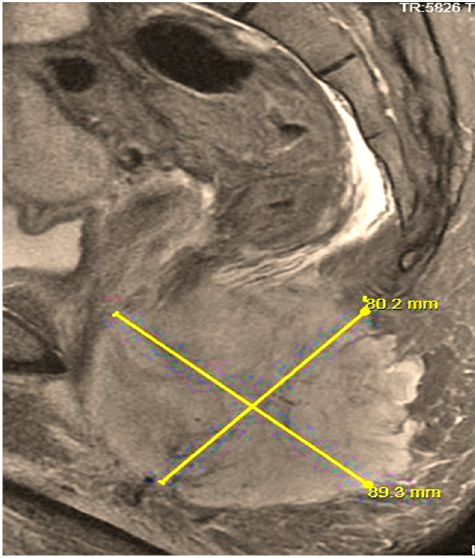
Figure 8. MRI (sagittal view) of 15 y/o patient with Stage IV perineal alveolar RMS.